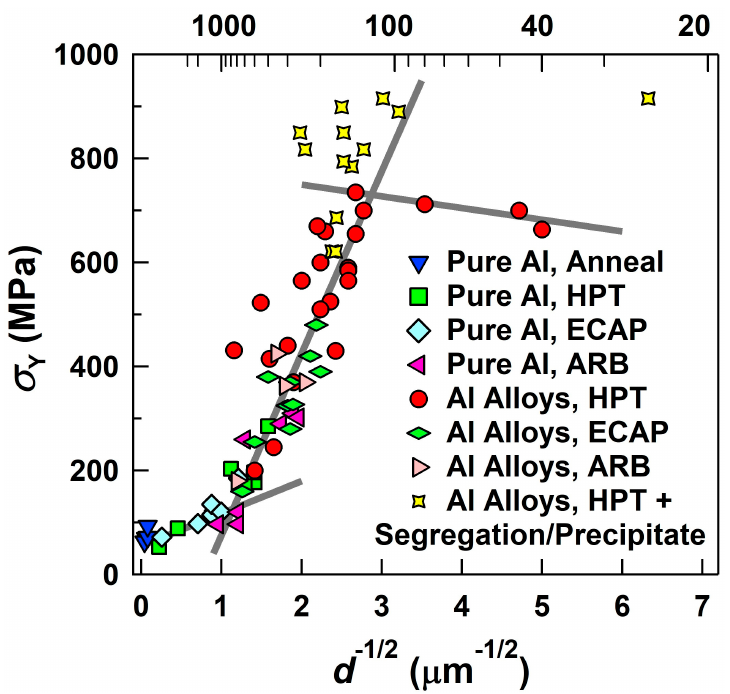
Figure 2. The Hall–Petch plot (yield stress, σ y , versus inverse square root of grain size, d ) and its breaks for aluminum and its alloys before and after severe plastic deformation by high-pressure torsion (HPT), equal-channel angular pressing (ECAP), and accumulative roll-bonding (ARB).